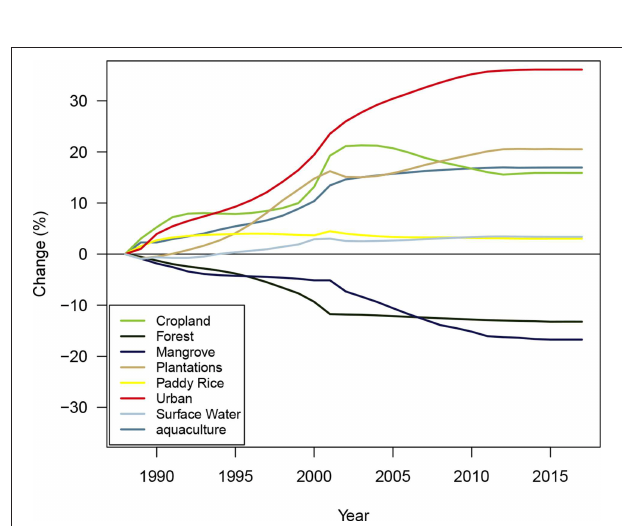
FIGURE 4 | The percent of change of coverage for each land cover class in Vietnam, using the 1988 area composition as the